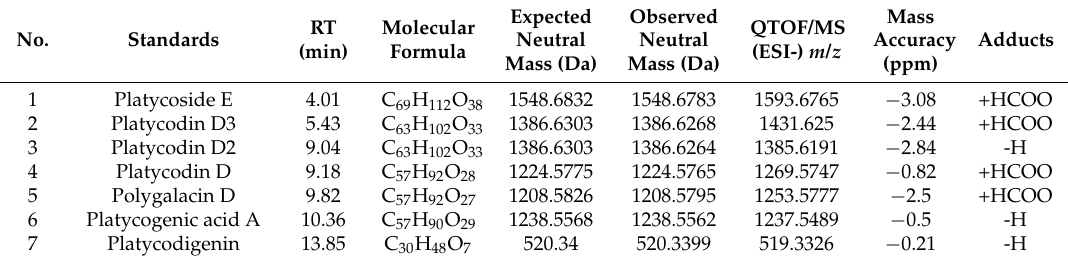
Table 1. List of seven standards analyzed by UPLC-QTOF/MS. RT, retention